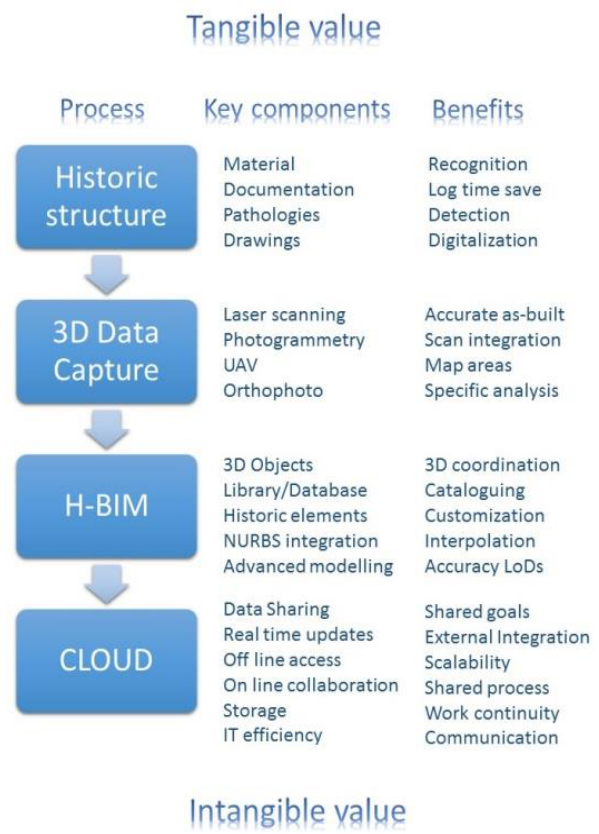
Figure 8. H-BIM. From tangible to intangible values of built heritage.